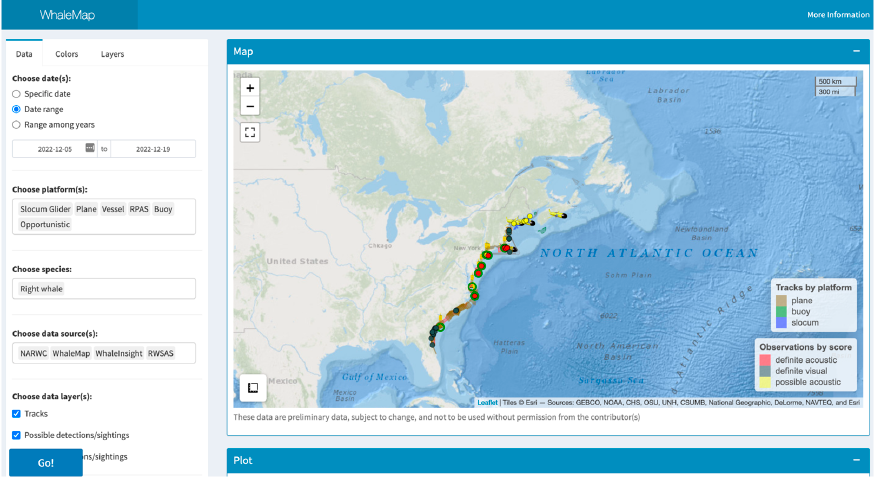
Figure 11. The WhaleMap web application designed to collate and display the latest whale positions (both visual sightings and acoustic detections) as well as survey effort (www.whalemap.org (accessed on 23 December 2022)).